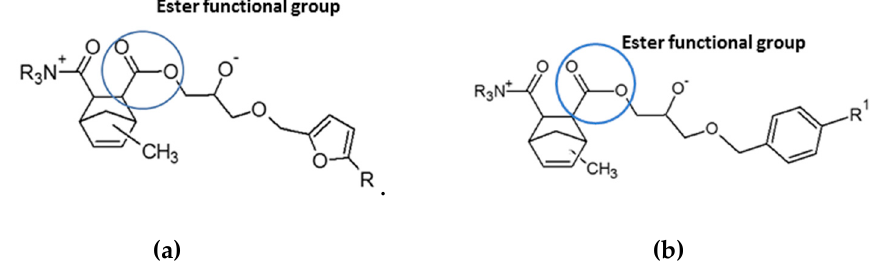
Figure 5. The curing of BOMF ( a ) and DGEBA ( b ) monomers leads to the formation of an ester group between the MNA and epoxy groups.